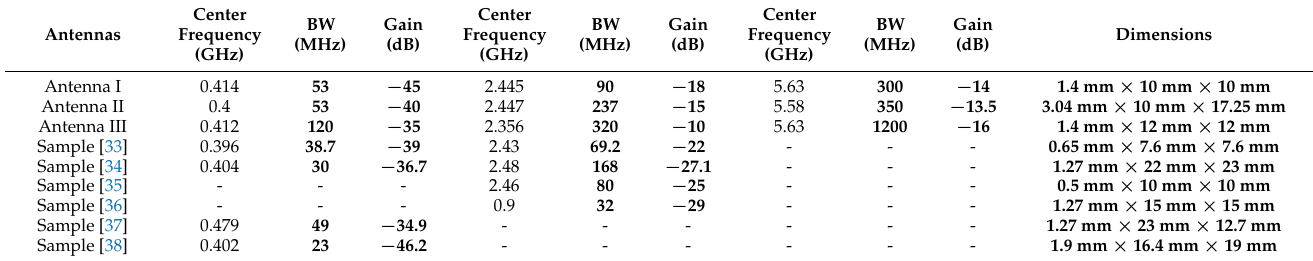
Table 1. Comparison between the presented designs and other reported samples.